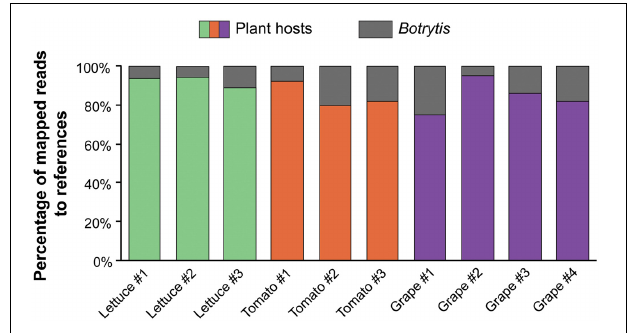
FIGURE 1 | Botrytis transcript abundance in infected plant tissues. Relative composition of RNAseq transcript reads between Botrytis and the three plant hosts (i.e., lettuce leaves, tomato fruit and grape berries).